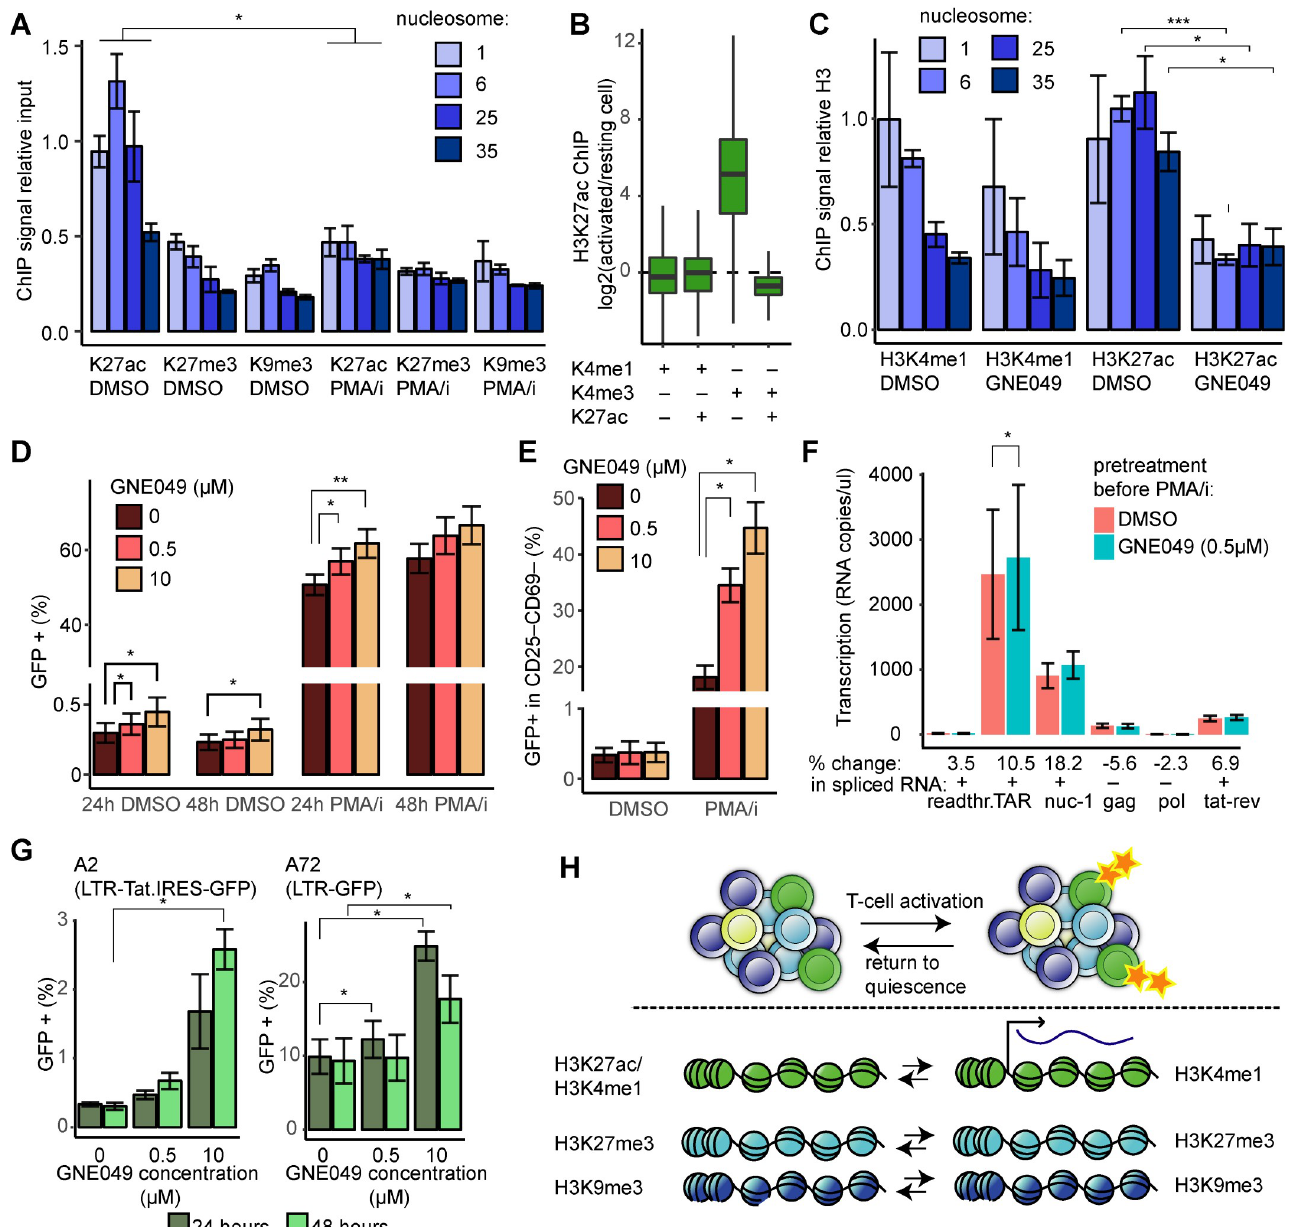
Fig 7. Enhancer H3K27ac modulates T-cell stimulation and HIV-1 latency reversal. ( A ) H3 modifications H3K27ac, H3K27me3 and H3K9me3 ChIP over the HIV-1 provirus. DNA and chromatin was isolated 48h after DMSO or PMA/i treatment of Bcl2-donor cells. Experiments performed in triplicate from a single donor, error bars represent standard deviation. ( B ) H3K27ac ChIP seq of the same sample as in A. Box plot of ratios for ChIP signal activated/resting cells in 500bp regions classified, based on independent published datasets, as enhancers (H3K4me1) or promoters (H3K4me1) either active (H3K27ac+) or poised (H3K27ac-). ( C ) H3K3me1 and H3K27ac ChIP signal over the provirus in 5A8 cells after treatment with GNE049 or DMSO for 3h. ( D ) HIV-1 latency reversal as measured by flow cytometry after T-cell activation in 5A8 in combination with CBP/P300 inhibitor GNE049 ( n = 6). ( E ) Effect of GNE049 on latency reversal in cells without surface markers for activated cells ( n = 2). ( F ) The effect of GNE049 on transcription in 5A8 cells as measured by RT-ddPCR ( G ) HIV-1 latency reversal as measured by flow cytometry after T-cell activation in A2 (LTR-Tat-IRES-GFP) and A72 (LTR-GFP) cells in combination with CBP/P300 inhibitor GNE049 ( H ) Graphical summary of the model with a heterogeneous HIV-1 reservoir of functionally intact latent proviruses and selective and transient activation of the provirus following T-cell activation. In panels C–G error bars represent s.e.m., in all panels � p < 0.05, �� p < 0.01, ��� p < 0.001 after unpaired t-